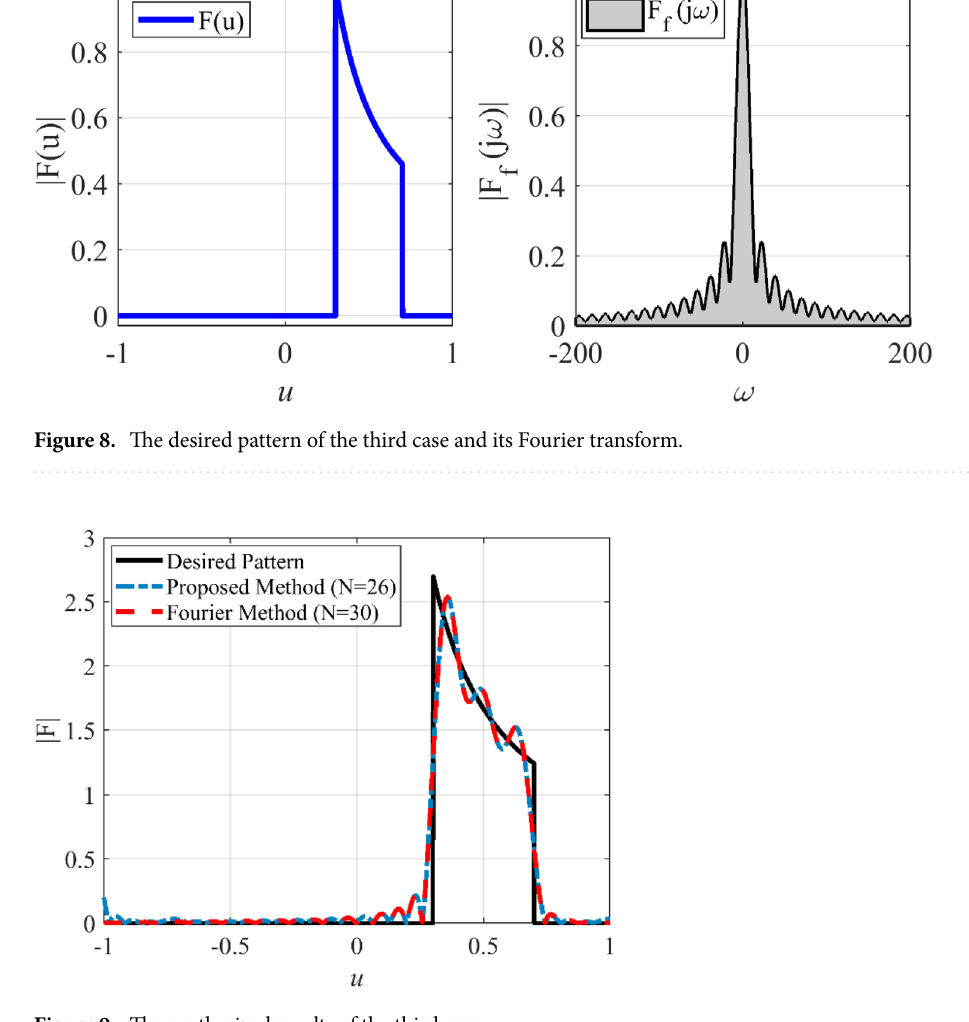
Figure 9. The synthesized results of the third